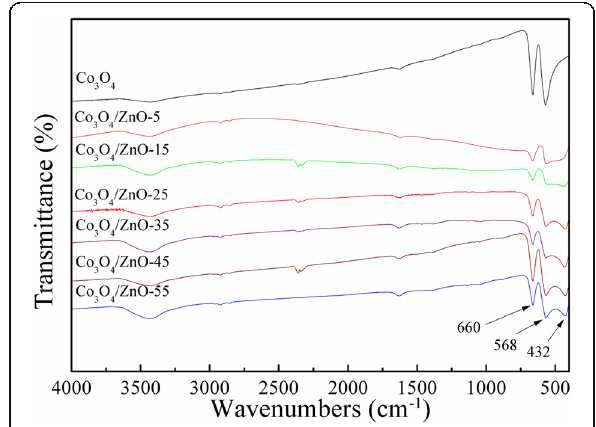
Fig. 4 FTIR spectra of synthesized Co 3 O 4 and